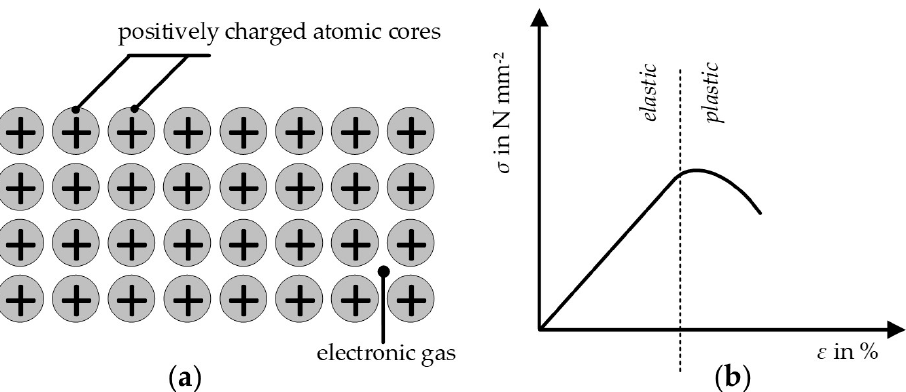
Figure 2. ( a ) Lattice structure of metals; ( b ) Stress − strain − diagram for materials without pronounced yield strength [6]